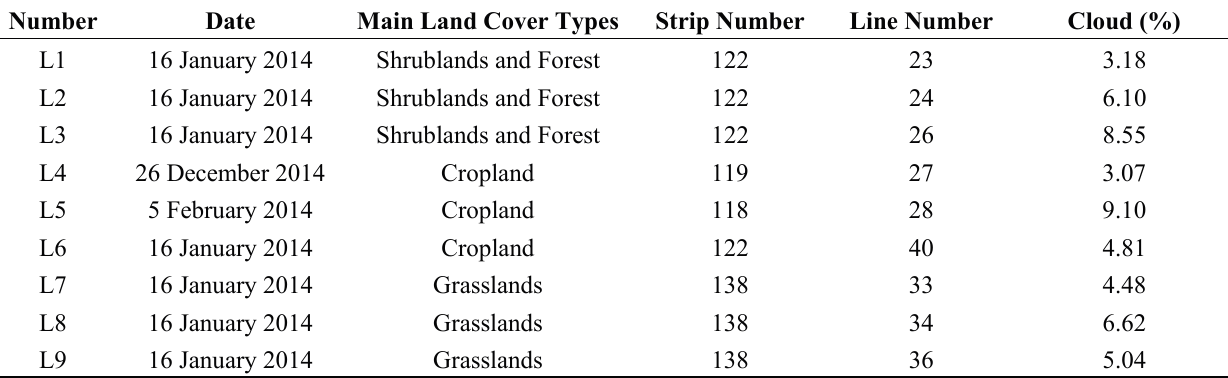
Table 2. Information on the Landsat 8 OLI data from January 16,